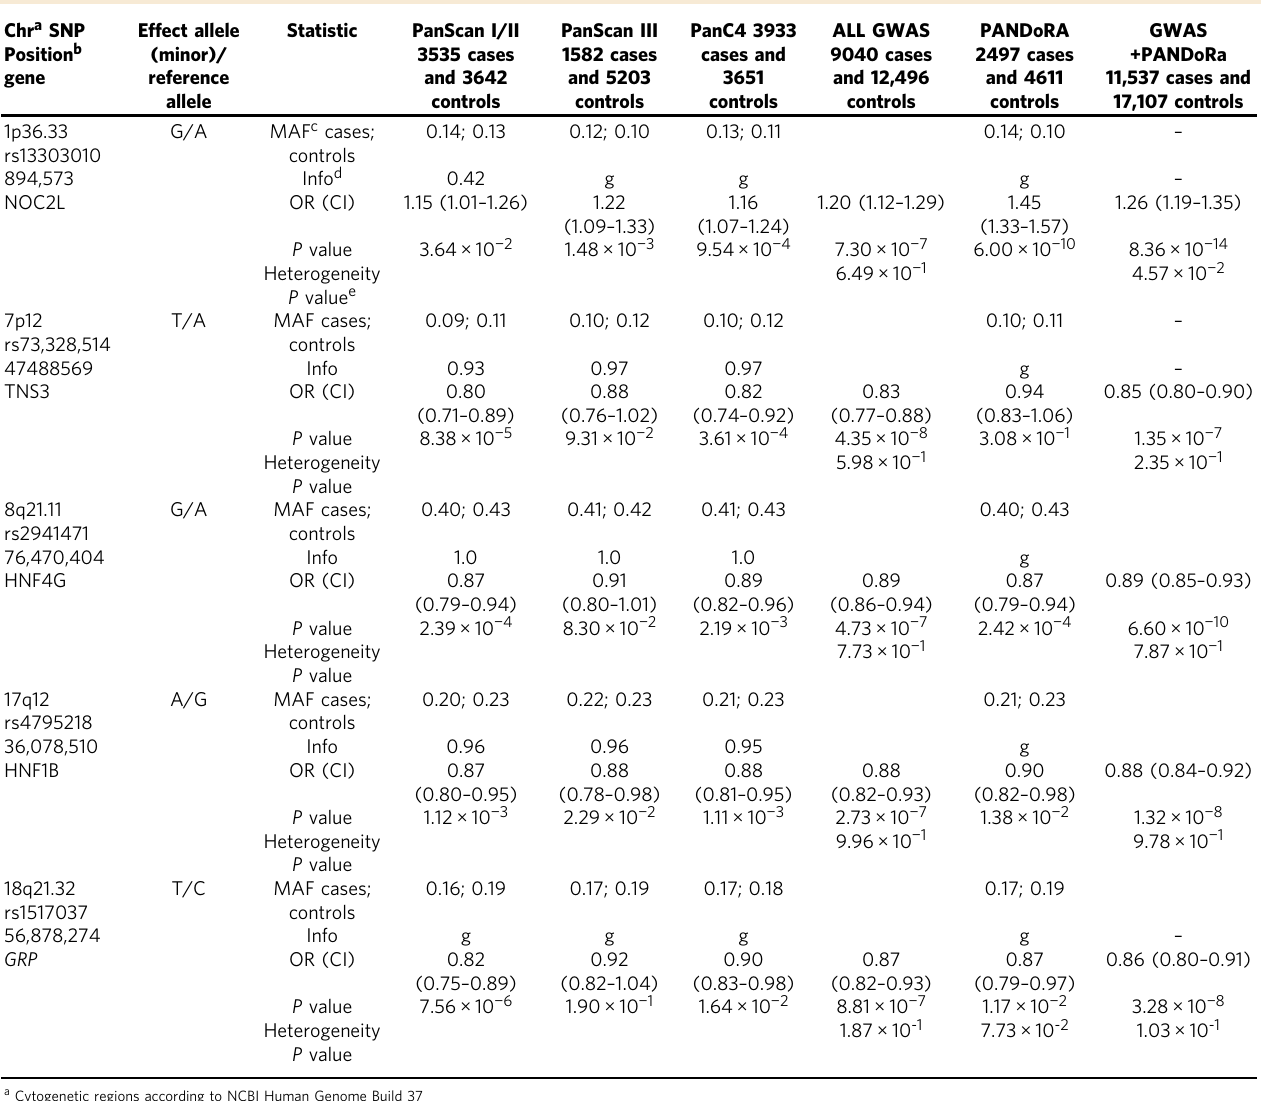
Table 1 Novel pancreatic cancer susceptibility loci Chr a SNP Position